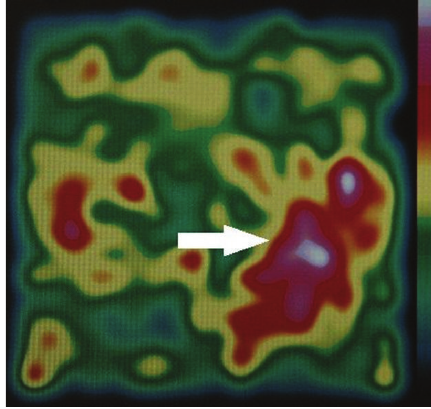
Figure 2: Lower left adenoma (white